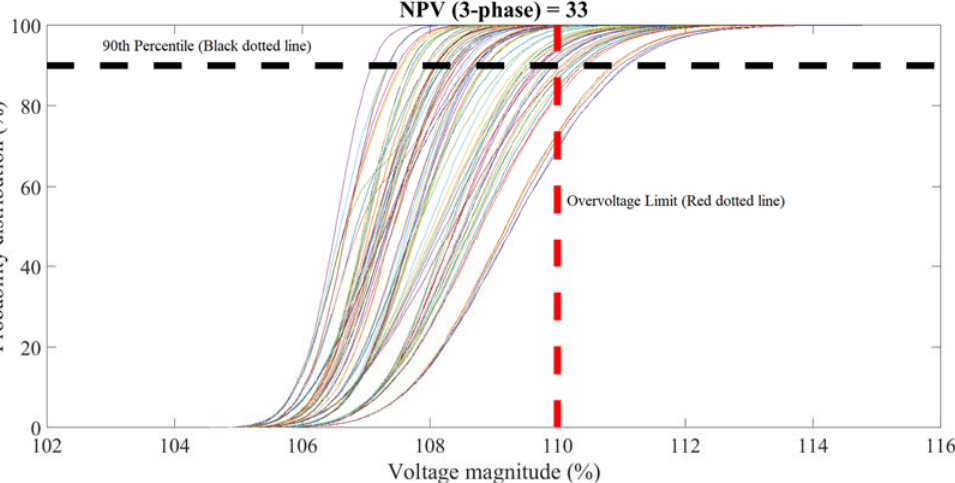
Figure 4. The probability distribution function for the studied distribution network applying the epistemic PDF with the levels of planning of 10% (Margin above the black dotted line) for 90th percentile values for the